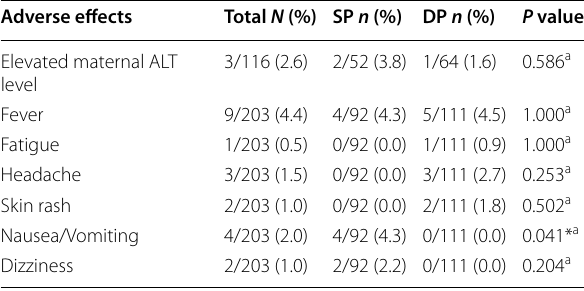
ALT Alanine aminotransferase a Fisher’s exact test *Significant at P < 0.05